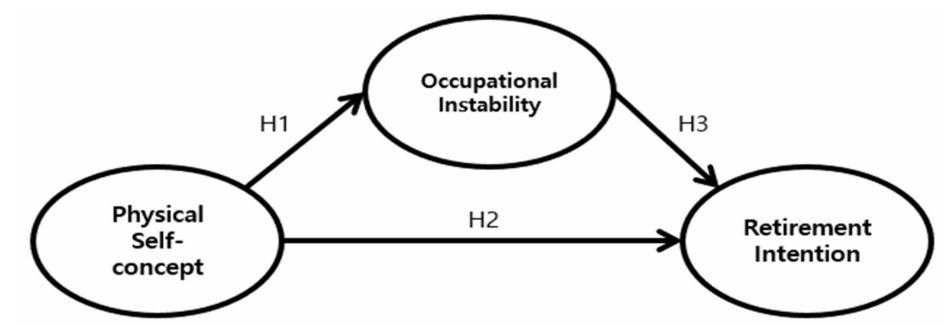
Figure 1. Hypothesized study